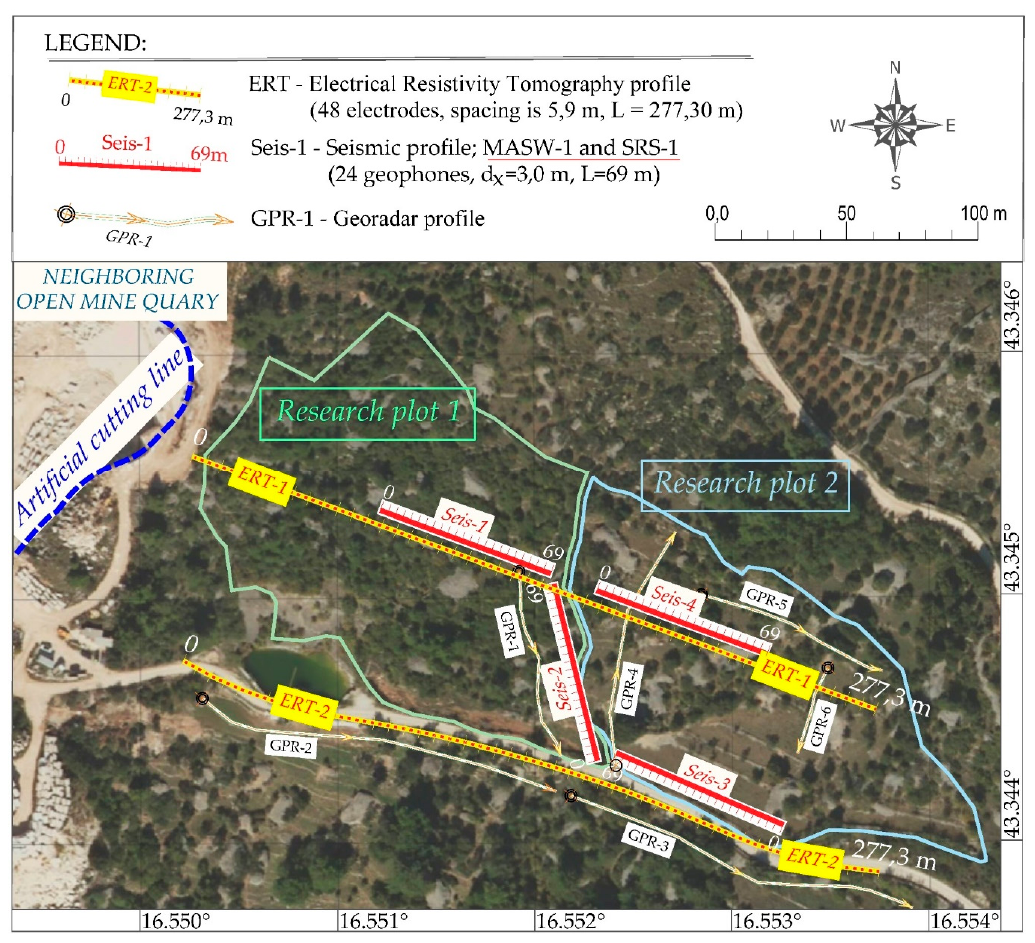
Figure 2. Geophysical profiles distributed on the two research plot areas. The profiles are mainly positioned around the two parallel profiles defined with electrical resistivity tomography (ERT-1 and ERT-2) profiles. The position of the neighboring quarry on the west side is also labeled.